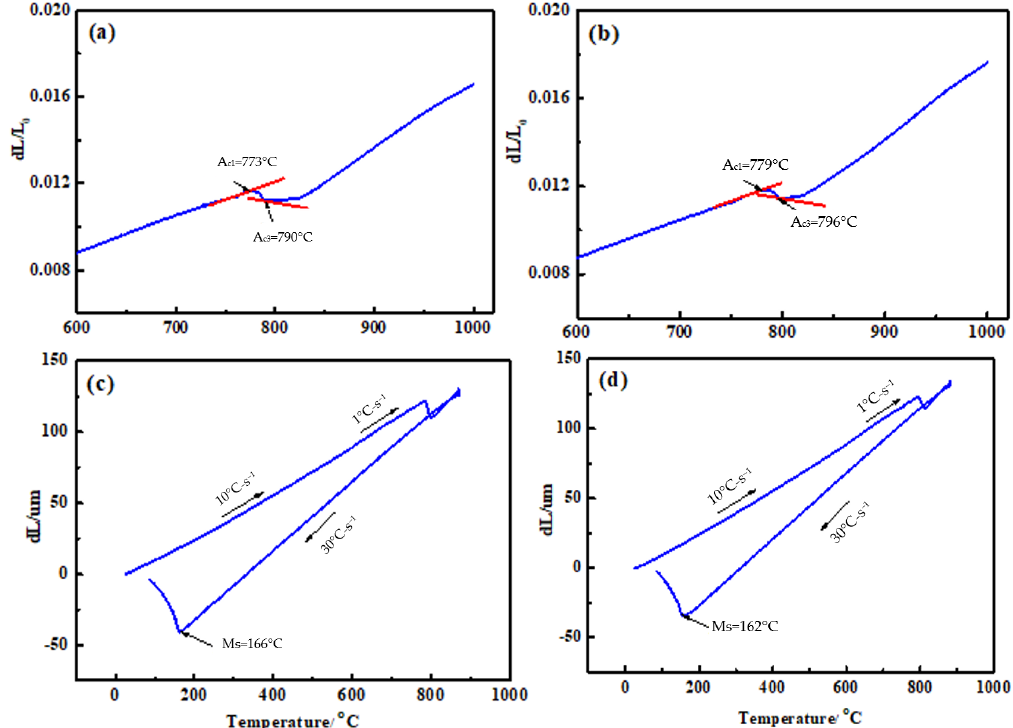
Figure 1. Dilation curves of the experimental steels: ( a , c ) GCr15SiMo; ( b , d ) GCr15Si1Mo.